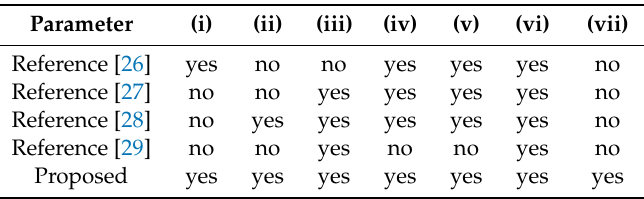
Table 1. Comparison of the proposed circuit with previously CFOA-based multifunction biquadratic filters in the literature [26–29].